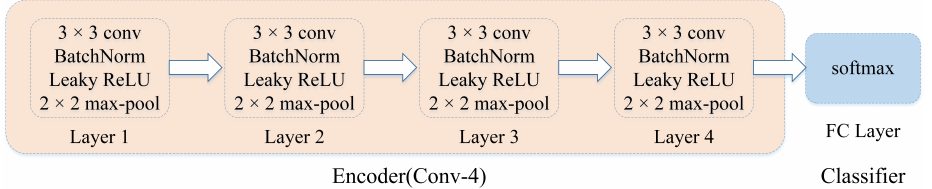
Figure 4. Structure and parameters of the pre-training